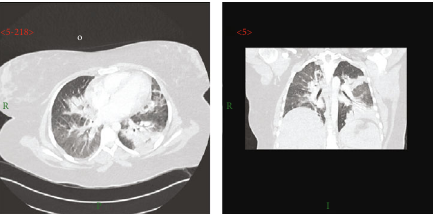
CTPA demonstrated COVID-19 pneumonitis throughout and left consolidation. Appearances in the left lung may suggest superadded bacterial consolidation on a background of bilateral COVID-19 pneumonitis. Appearances in the right lung are more suggestive of COVID-19